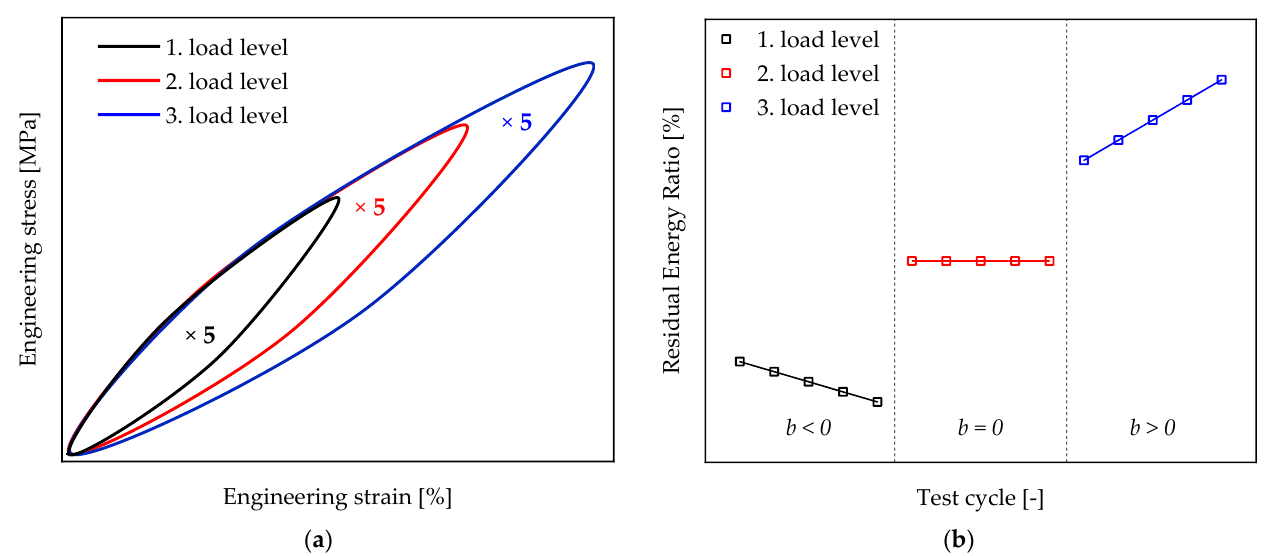
Figure 5. Determination of the residual energy ratio within a load level: ( a ) schematic hysteresis curves of different load levels; ( b ) schematic approximation of the determined residual energy ratio of a load level by straight lines.